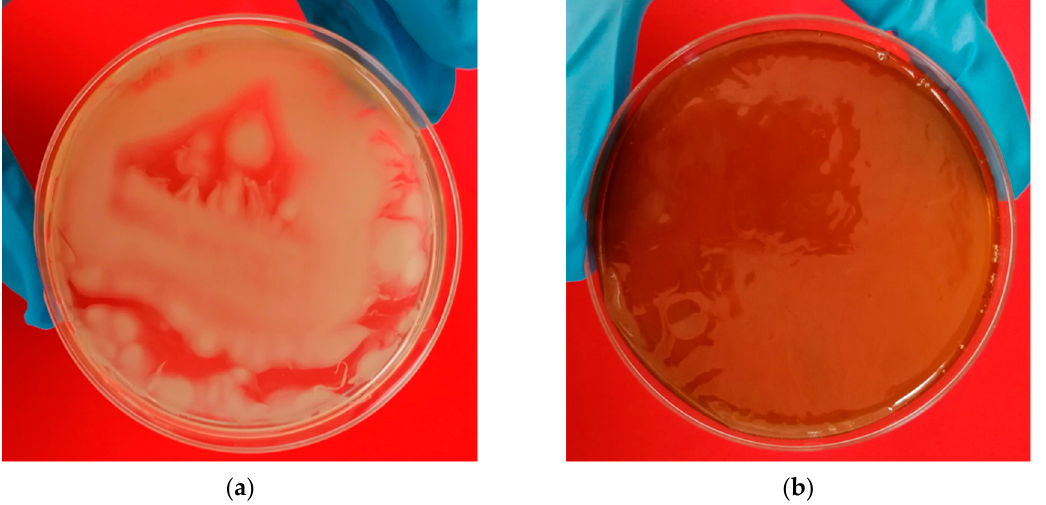
Figure 3. Images of bacterial cellulose films formed at the air–liquid interface of the culture medium: ( a ) Bacterial cellulose film growing in control culture medium showing non-homogeneous growth on the free surface of the Petri dish; ( b ) Bacterial cellulose film synthesized in bagasse–potato culture medium growing homogeneously covering the Petri dish surface.